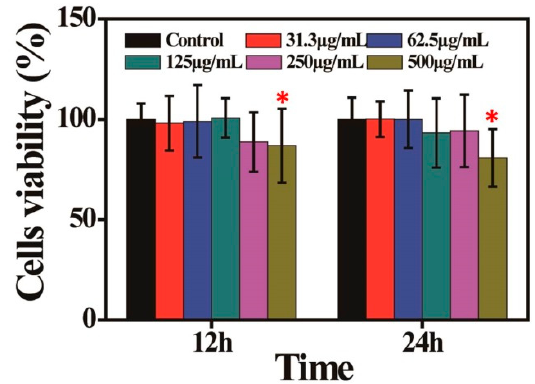
Figure 6. Cytotoxicity of different concentrations of MnO 2 nanosheets via 3-[4,5-dimethylthiazol-2-thiazolyl]-2,5-diphenyl tetrazolium bromide (MTT) assay. Vero cells were incubated with MnO 2 nanosheets separately for 12 and 24 h. Statistical significance was decided with a * p < 0.05.